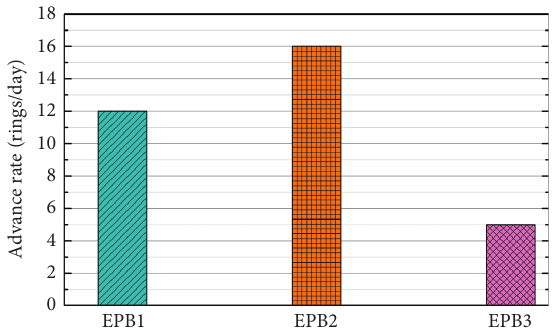
Figure 11: Daily advance rate of the EPBs.